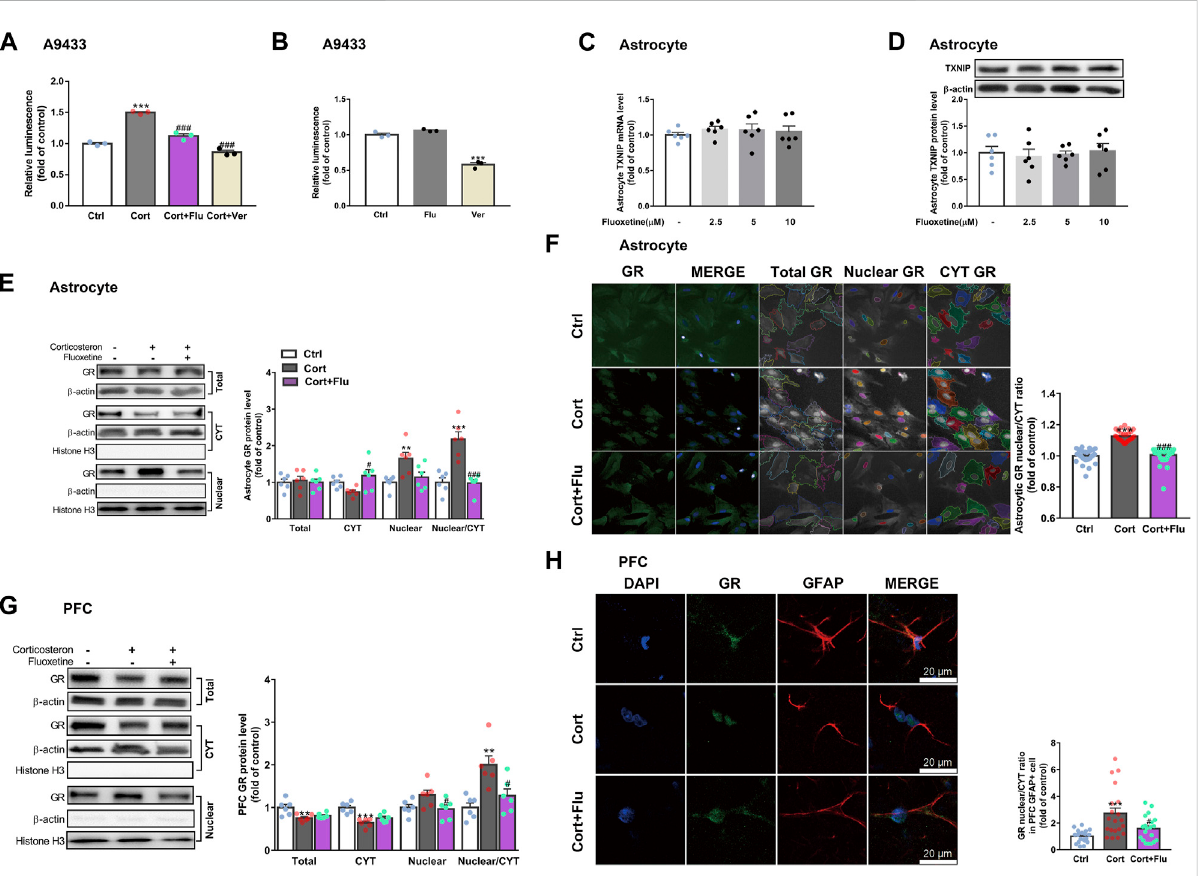
FIGURE 6 Fluoxetine restricts glucocorticoid receptor nuclear translocation of astrocytes in vivo and in vitro. (A) Fluoxetine (5 μ M) and verapamil (80 μ M) signi fi cantly reduced corticosterone-induced TXNIP expression in A9433 cells, n = 3 cell cultures/group; P CortxCort + Flu < 0.0001; P CortxCort + Ver < 0.0001. (B) Fluoxetine (5 μ M) had no effect on TXNIP expression in normal A9433 cells, but verapamil (80 μ M) signi fi cantly reduced TXNIP expressioninnormalA9433cells, n =3cellcultures/group; P CtrlxFlu=0.1597; P CtrlxVer < 0.0001. (C) TXNIPmRNAlevelofnormalastrocytes withouttreatmentortreatedwith fl uoxetine(2.5,5,and10 μ M), n =6cellcultures/group; P CtrlxFlu2.5=0.7240; P CtrlxFlu5=0.7796; P CtrlxFlu10= 0.9324. (D) TXNIP protein level of normal astrocytes without treatment or treated with fl uoxetine (2.5, 5, and 10 μ M), n = 6 cell cultures/group; P CtrlxFlu2.5 = 0.9509; P CtrlxFlu5 = 0.9961; P CtrlxFlu10 = 0.9931. (E) GR (total, CYT and nuclear fractions) protein levels in corticosterone (100 nM) and fl uoxetine (5 μ M) treated primary astrocytes, n = 6 cell cultures/group; Total: P CortxCort + Flu = 0.9093; CYT: P CortxCort + Flu = 0.0163; Nuclear: P CortxCort + Flu = 0.0532; Nuclear/CYT: P CortxCort + Flu < 0.0001. (F) Immunostaining of GR (green), and DAPI (blue) in corticosterone (100 nM) and fl uoxetine (5 μ M) treated primary astrocytes, n = 30 fi elds/group; P CortxCort + Flu < 0.0001. (G) GR (total, CYT and nuclear fractions) protein levels in PFC of rats treated with corticosterone (40 mg/kg) and fl uoxetine (10 mg/kg), n = 6 animals/group; Total: P CortxCort + Flu = 0.6424; CYT: P CortxCort + Flu =0.1650;Nuclear: P CortxCort + Flu= 0.0484; Nuclear/CYT: P CortxCort+ Flu =0.0137. (H) Immunostaining of GR (green), GFAP (red) and DAPI (blue) in PFC of rats treated with corticosterone (40 mg/kg) and fl uoxetine (10 mg/kg), scale bar = 20 μ m, n = 20 cells/ group; P CortxCort + Flu = 0.0390. All data were expressed as mean ± SEM, ** p < 0.01, *** p < 0.001 vs. Ctrl (control) group, # p < 0.05, ## p <